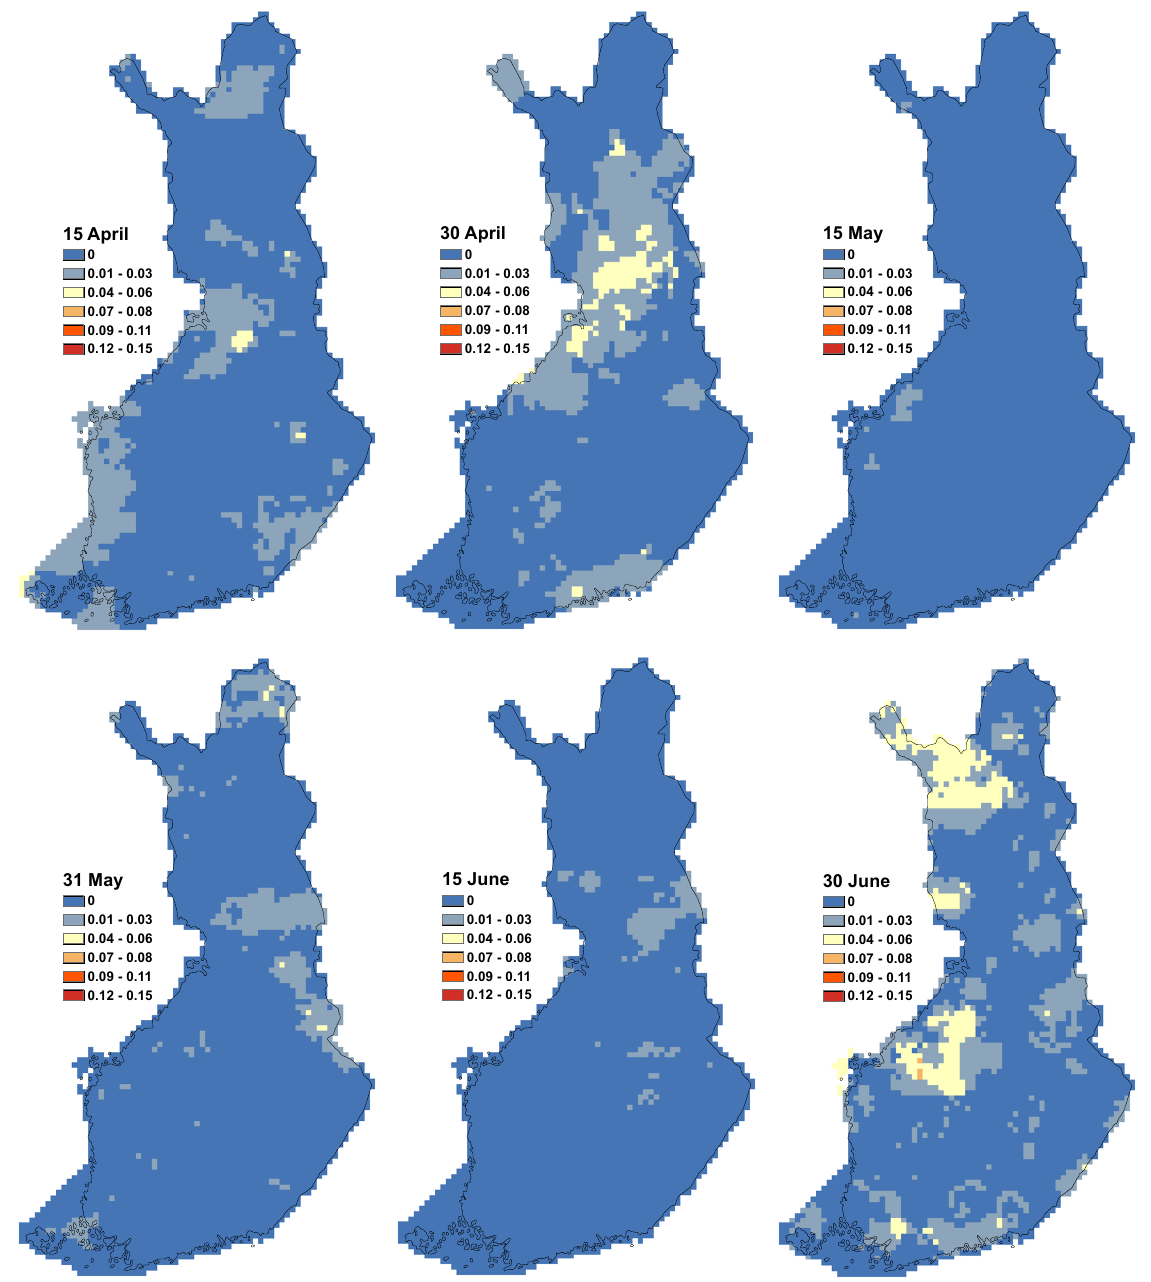
Fig. 4a. Probabilities of repeated rains lasting for at least for three weeks for the periods that ended on 15 April to 30